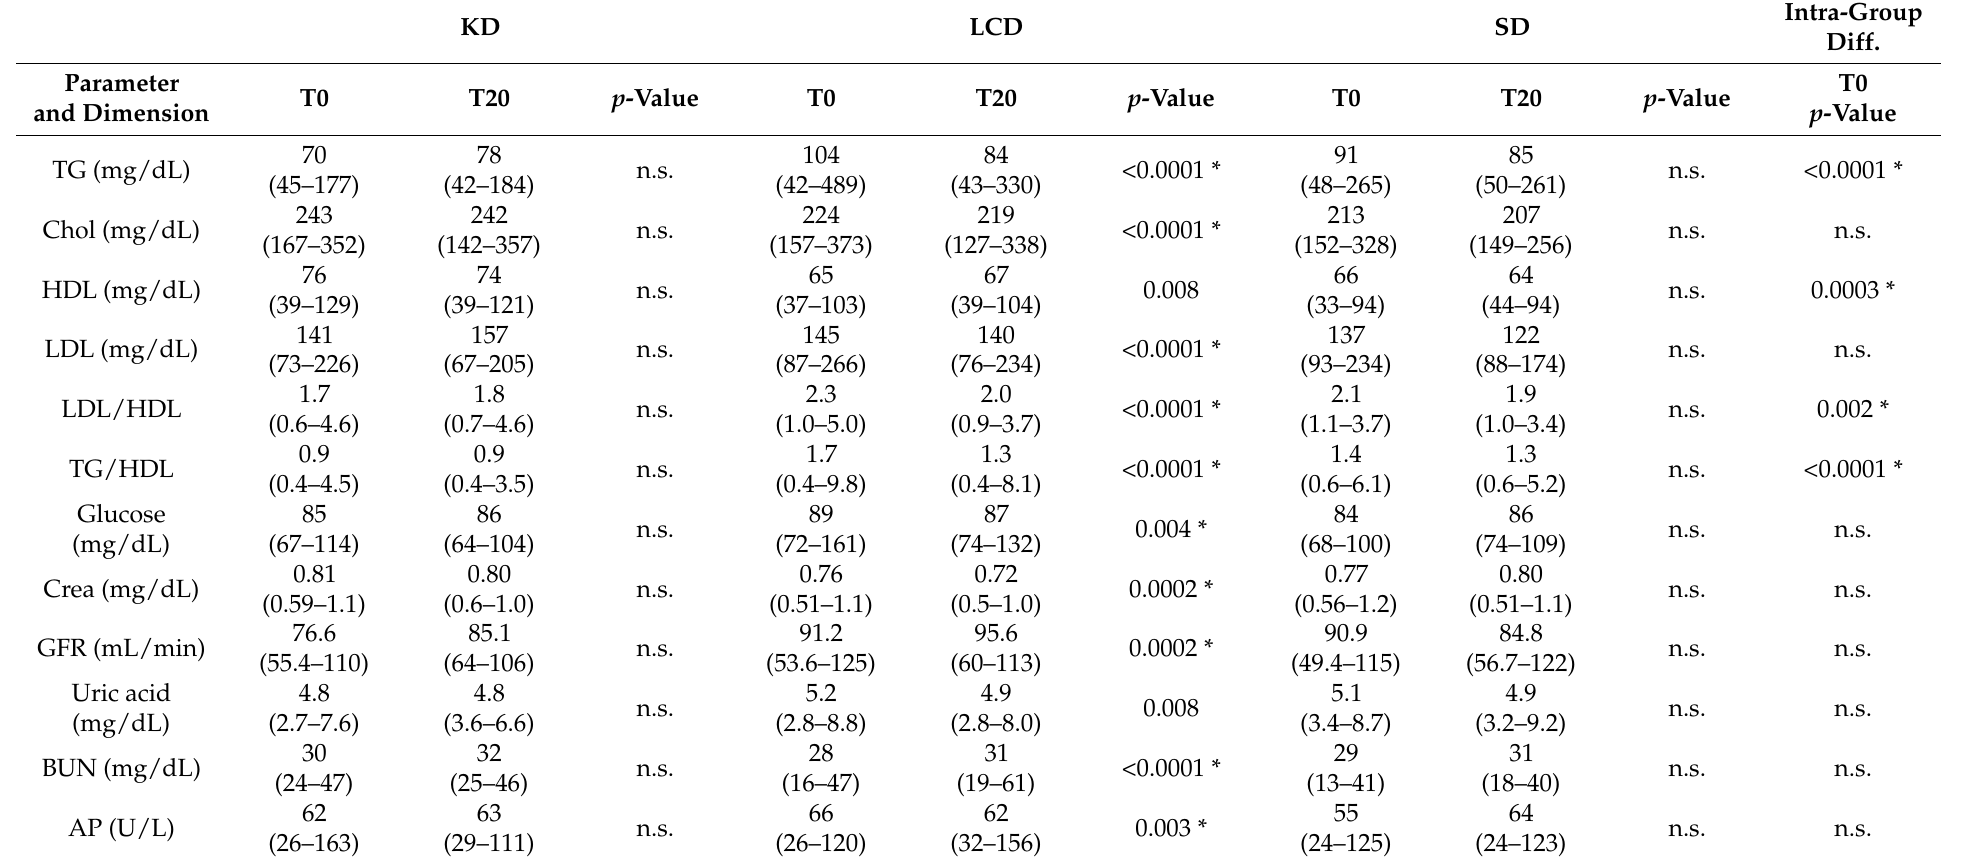
Table 5. Blood parameters at start and end of